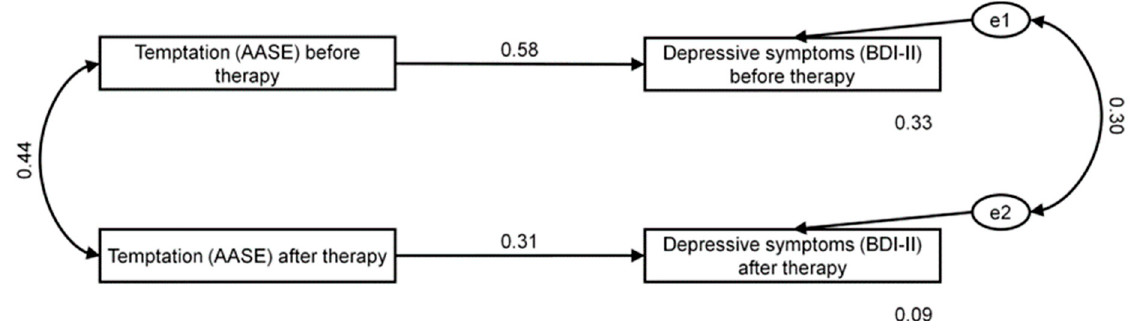
Figure 3. AASE temptation as predictor of depressive symptoms in the investigated group before